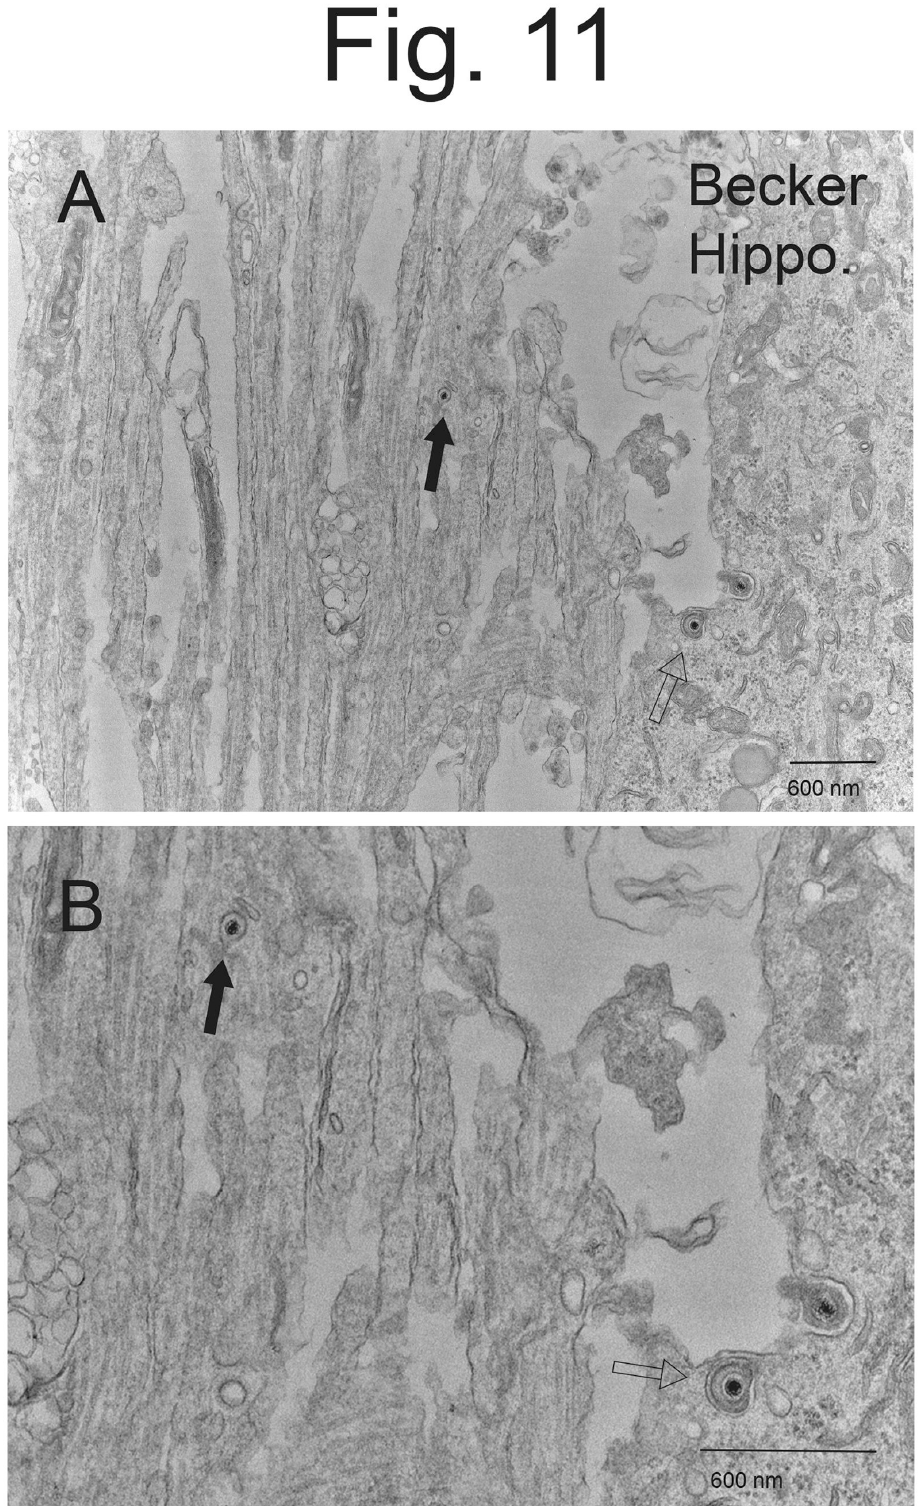
Figure 11. EM images of a hippocampal neurite containing a PRV unenveloped capsid. Panel ( A ) shows a PRV unenveloped capsid inside a rat hippocampal neuron neurite (solid arrow). This particle can be compared to enveloped virus particles in the cytoplasm of a nearby neuron (open arrow). Panel ( B ) shows a higher magnification of these particles. It appears that the unenveloped capsid is attached onto a membrane vesicle inside the neurite (solid